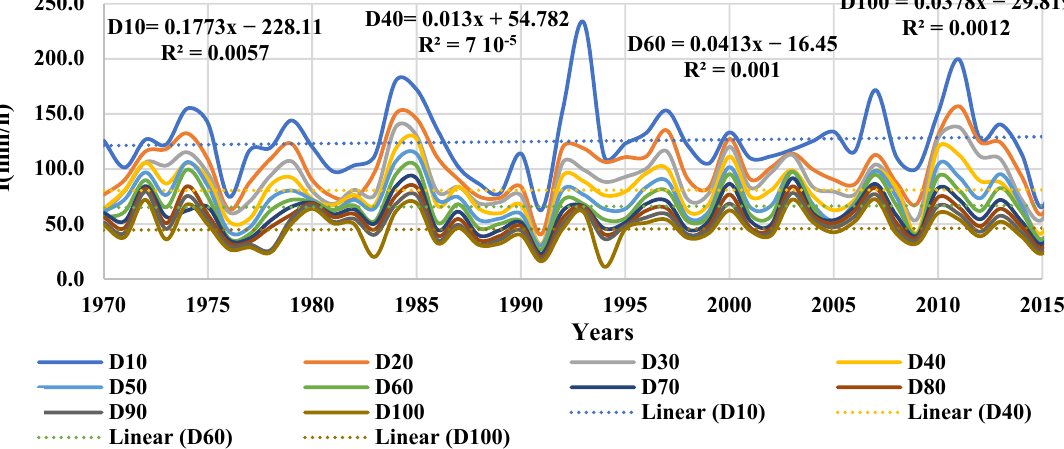
Figure 4. Time series of maximum annual intensities for a given rainfall duration in minutes.